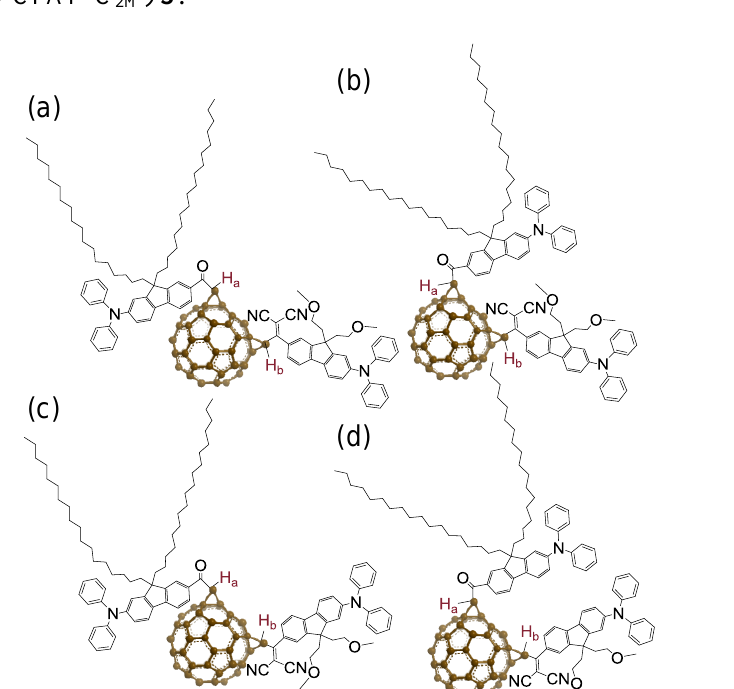
Figure 4. Four possible structural conformers for each regioisomer of C (>DPAF-C )(>CPAF-C ) 3 60 18 2M